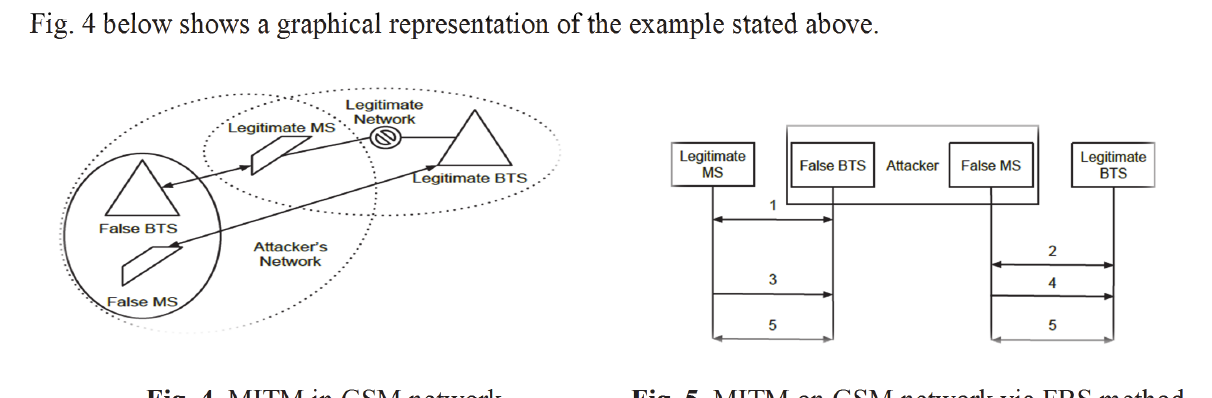
Fig. 4. MITM in GSM network Fig. 5. MITM on GSM network via FBS method